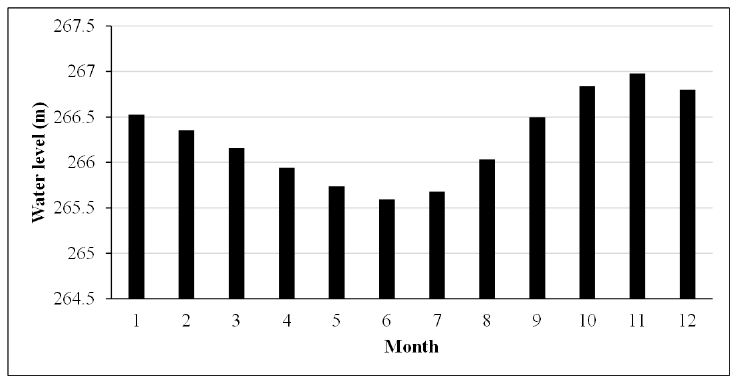
Figure 10. Monthly average water level of the SPLC from 1992 to 2016.